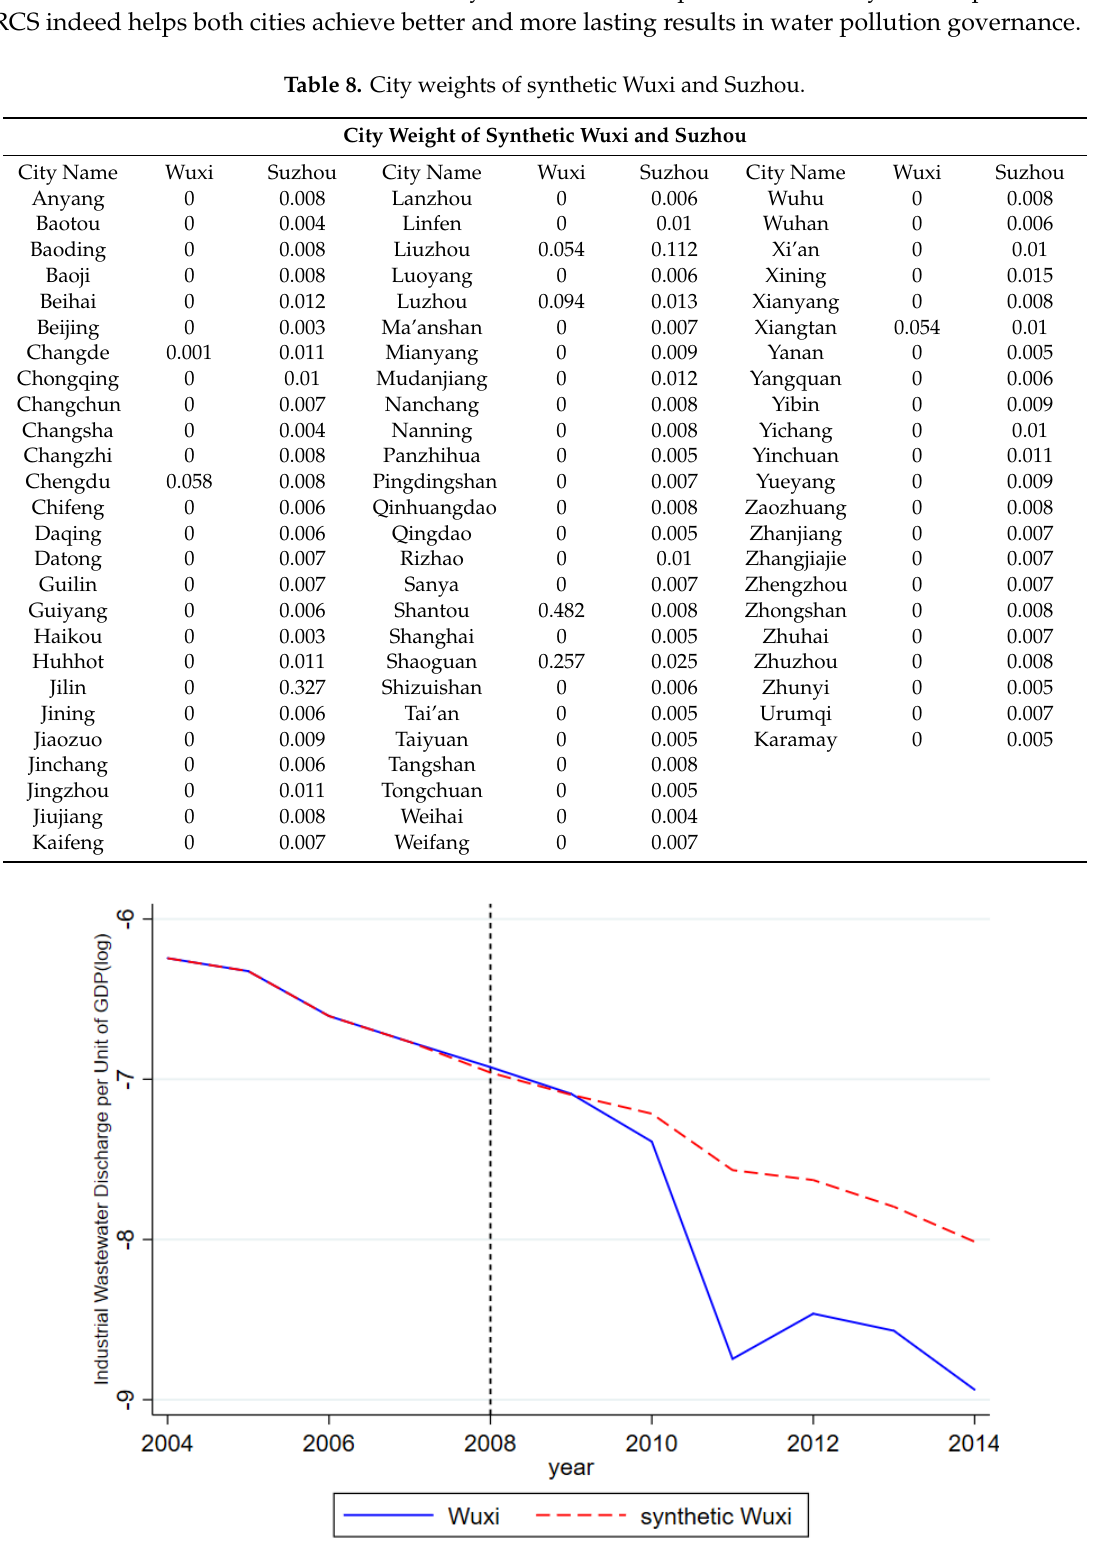
Figure 5. Policy effects of Suzhou and synthetic Suzhou. 7. Discussion Navigating effective approaches to remediate and prevent water pollution is a challenging task for developing economies worldwide. By gauging the effectiveness of the RCS, an institutional innovation pioneered by a number of Chinese local governments and subsequently promoted and propagated nationwide, this paper identifies a promising avenue through which water pollution can be more effectively managed in China. From a theoretical standpoint, a dual-track mechanism exemplified by the adoption of the RCS plays a pivotal role in the improvement of the local water environment. Specifically, (1) from a top-down perspective, the authoritarian nature of China’s political system ensures that central directives can be efficiently promoted as mandatory goals that